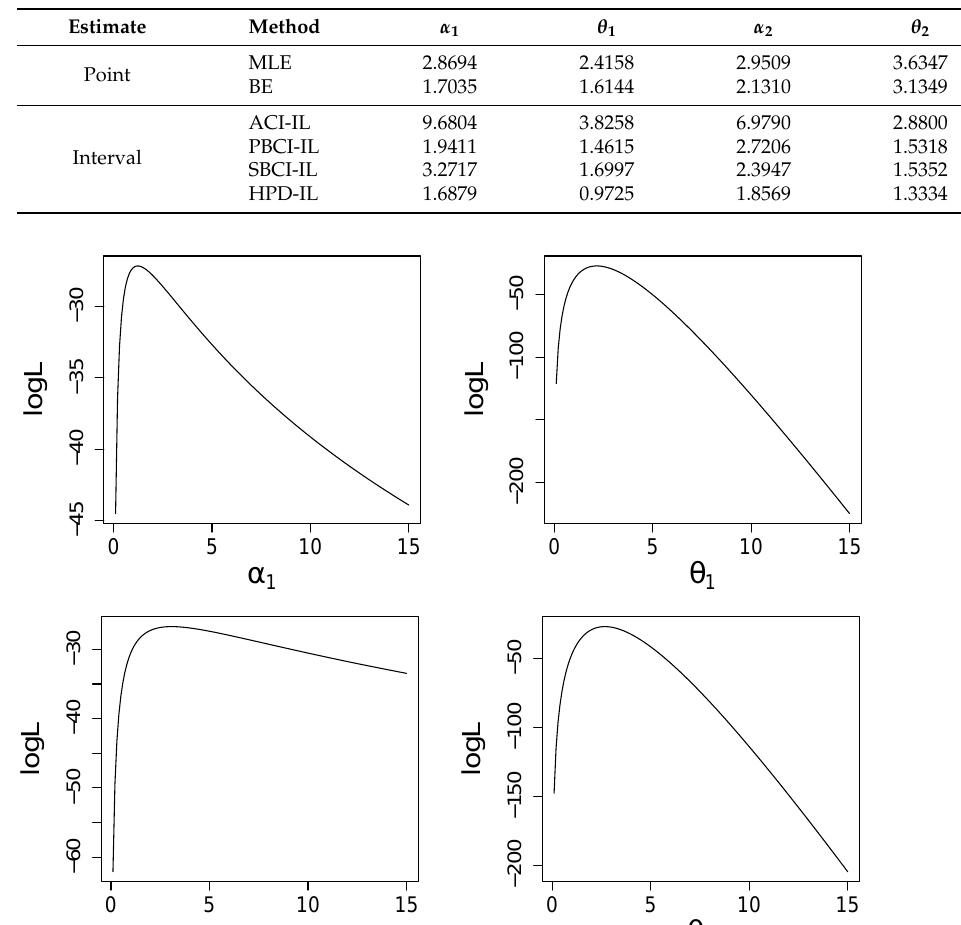
Table 14. Parameter estimates for the competing risks dataset.